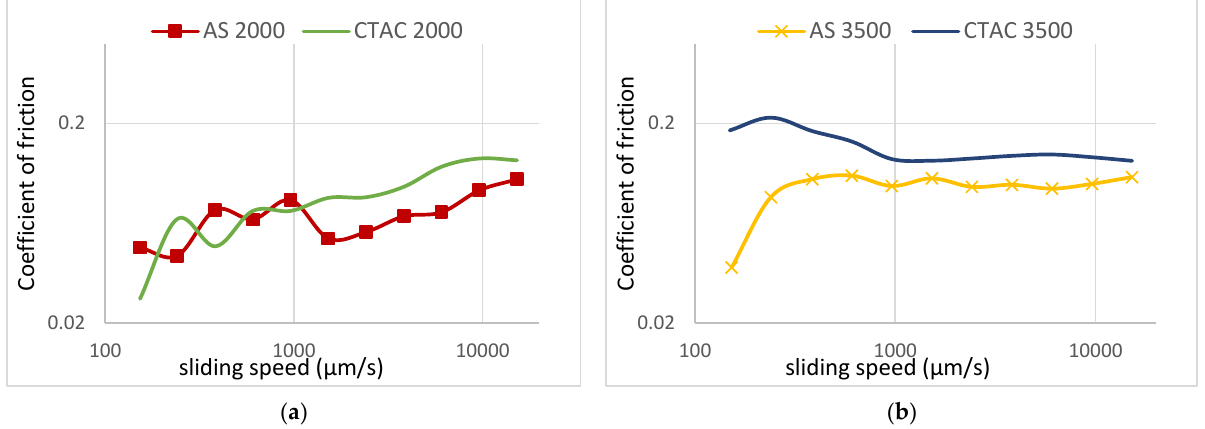
Figure 7. Stribeck curve of AminoSensyl™ conditioners and CTAC conditioners formulated at varied mixing speeds ( a ) 2000 rpm ( b ) 3500 rpm.